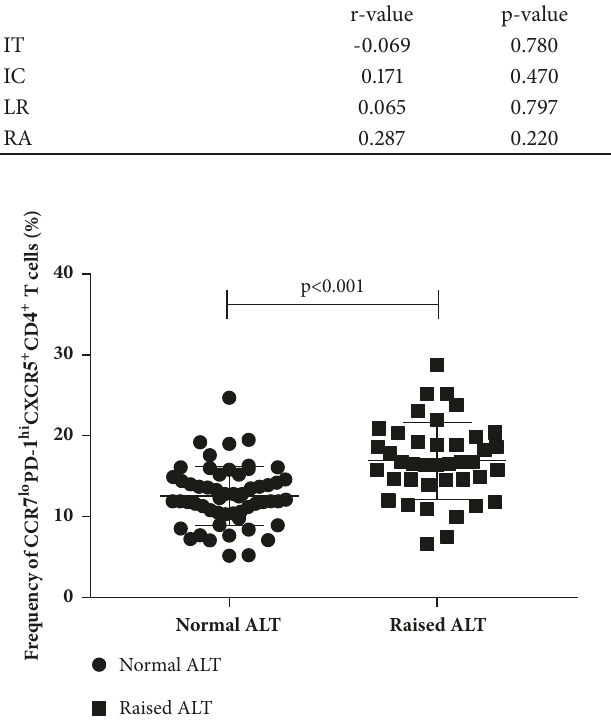
Figure 4: Frequencies of CCR 7 lo PD- 1 hi CXCR5 + CD4 + T cells among all CXCR5 + CD4 + CD3 + cells in the people with normal ALT and raised ALT. Difference between two group was significant (p < 0.001). The horizontal lines show the